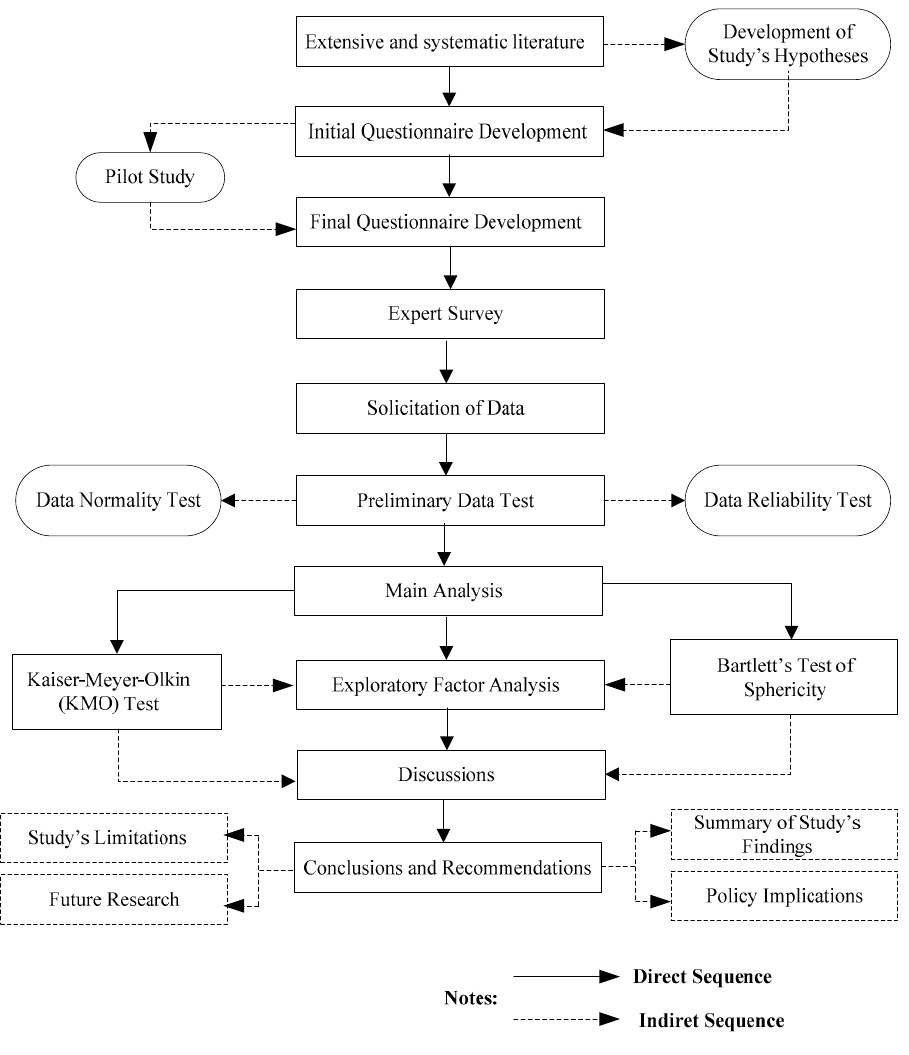
Figure 1. Flowchart of the methodological approach summary.